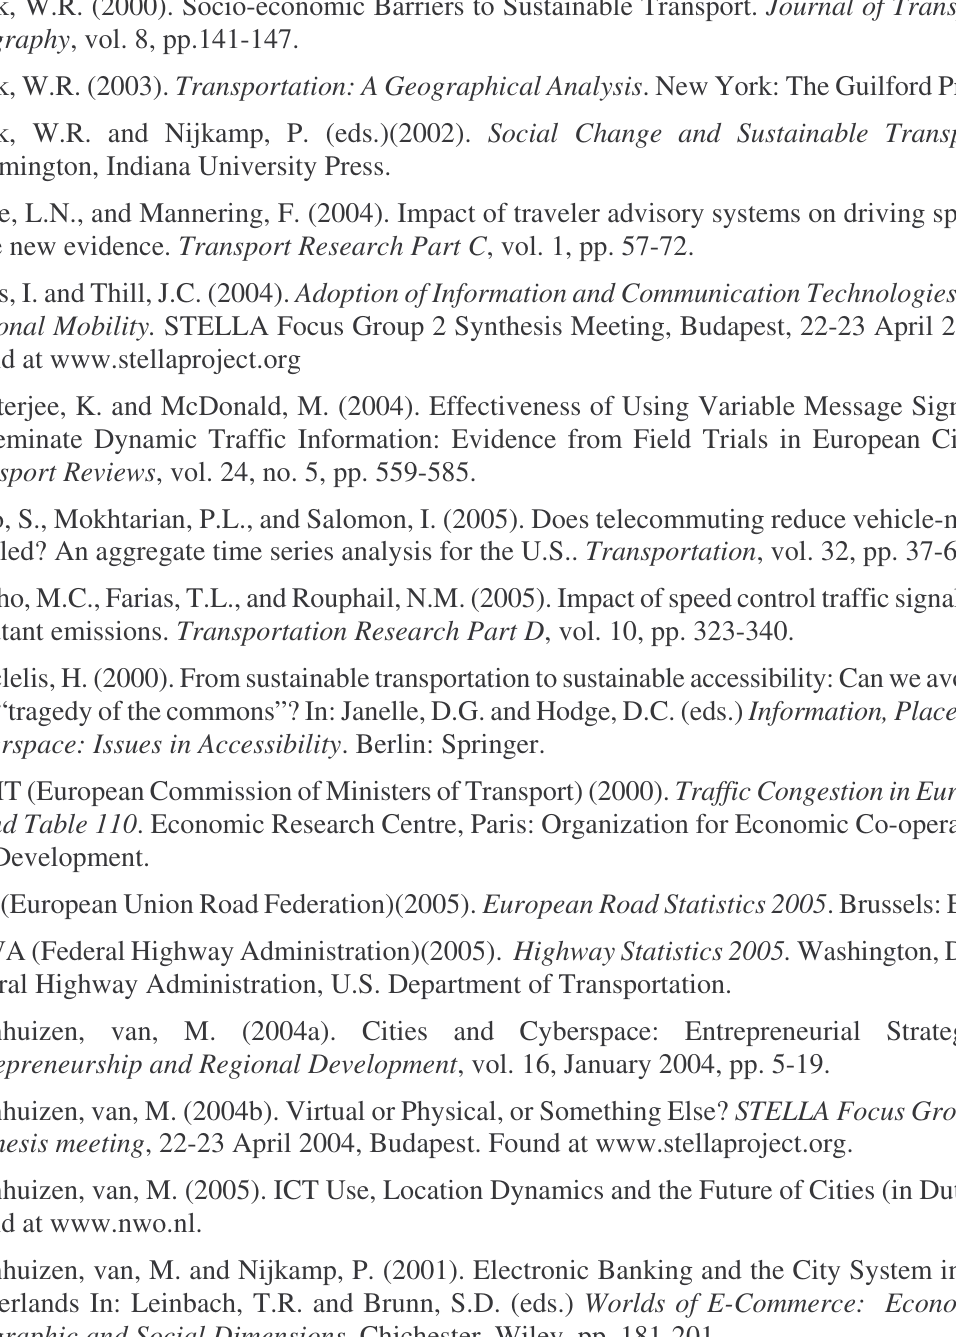
Round Table 110 . Economic Research Centre, Paris: Organization for Economic Co-operation and